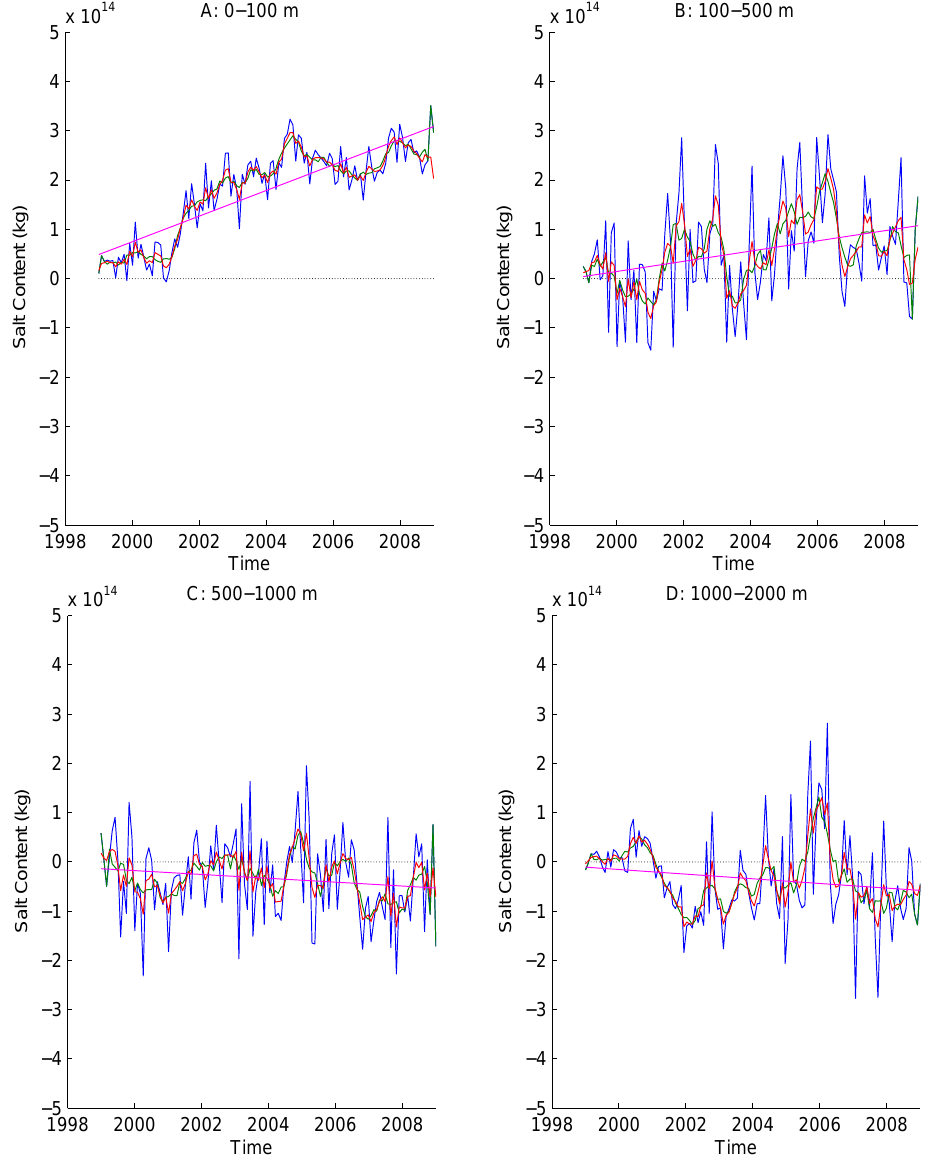
Fig. 13. SCD time series for the North Atlantic in selected layers: (a) 0–100m; (b) 100–500m; (c) 500–1000m; (d) 1000–2000m;